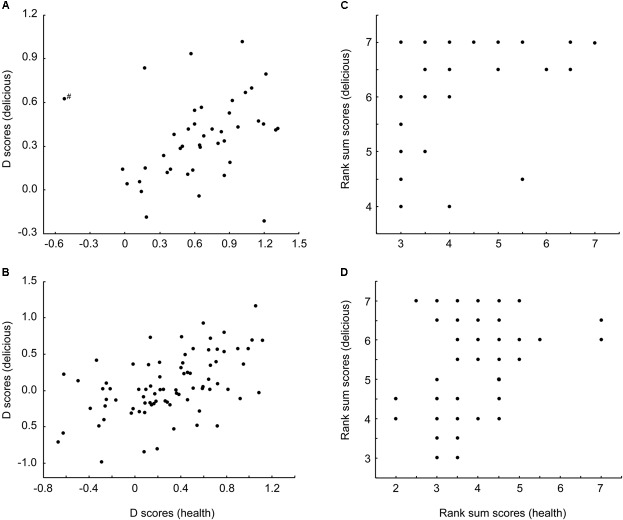
Both implicit (A,B) and explicit (C,D) measures revealed that both men (A/C) and women (B/D) exhibited significant positive correlations between the strengths of association between meat and the attributes healthy and delicious, respectively as measured by IAT D scores and explicit rank sums. #Indicates a bivariate outlier that was removed prior to correlation analysis.